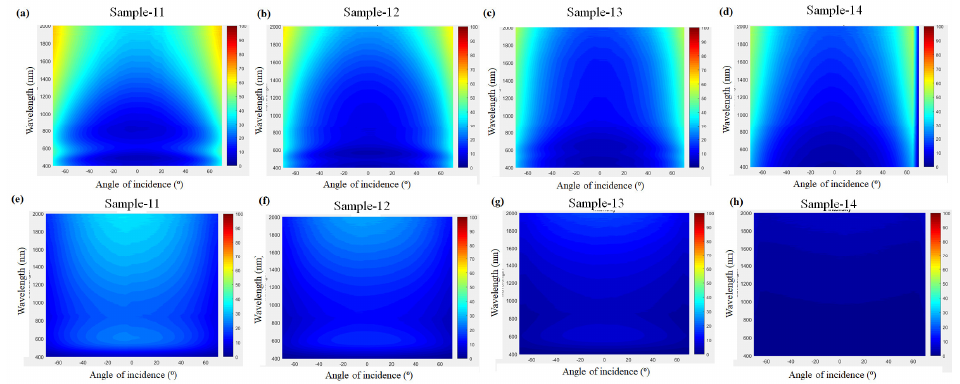
Figure 8. Measured s-polarized ( a – d ) reflectance and ( e – h ) transmittance versus wavelength and angle of incidence for TiN NRA.